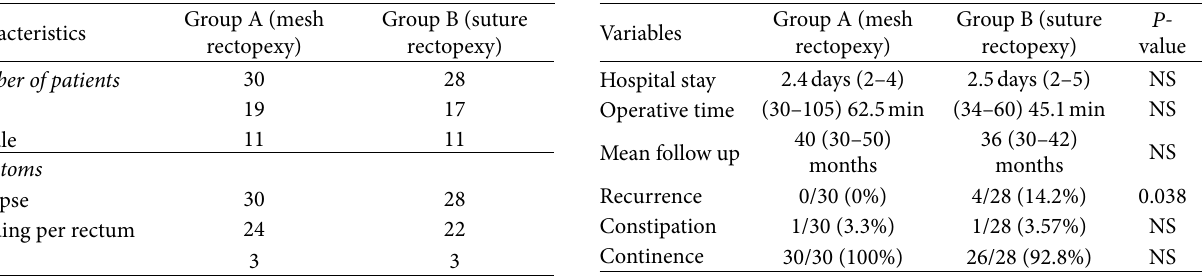
Table 2: Demographic data in both groups. Table 3: Follow up results in both